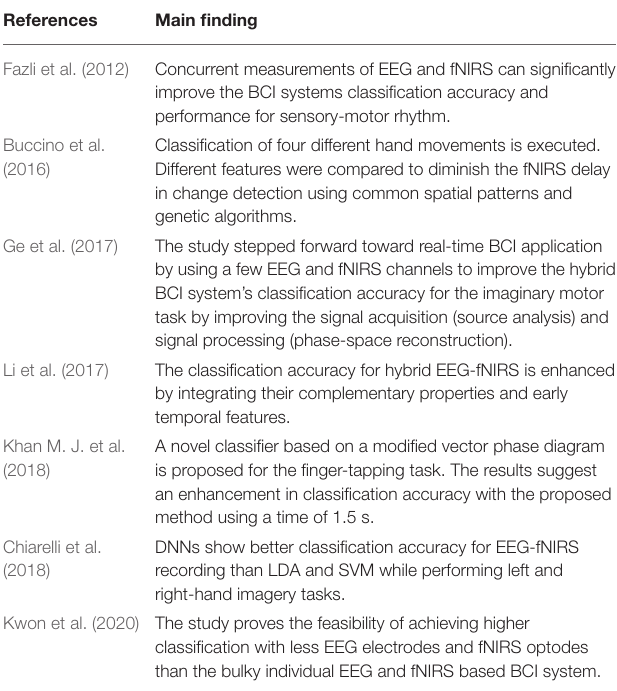
TABLE 7 | Summary of fused EEG-fNIRS studies for motor